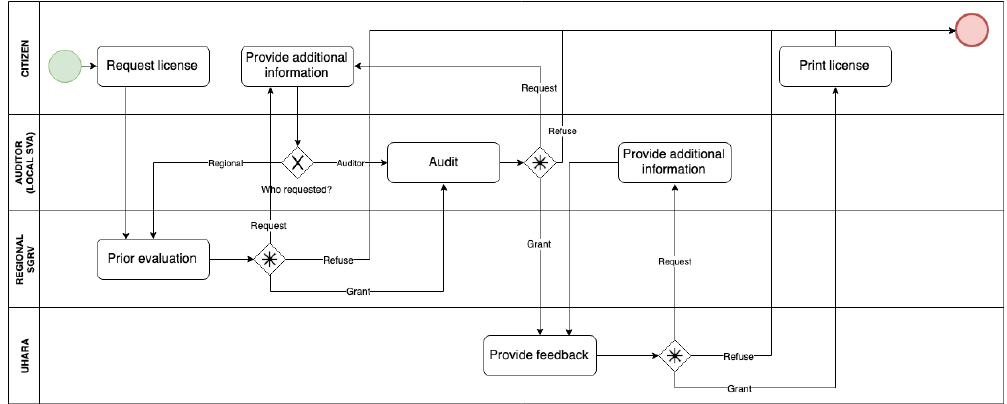
Figure 5. Service business